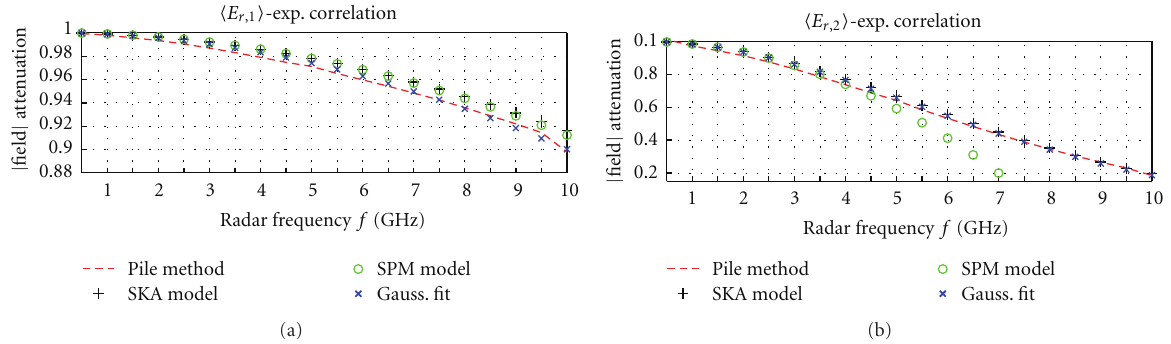
Figure 3: The same simulation parameters as in Figure 2 (with L c A = 10 . 0mm and L c B = 30 . 0 mm), but for exponential correlation surfaces.